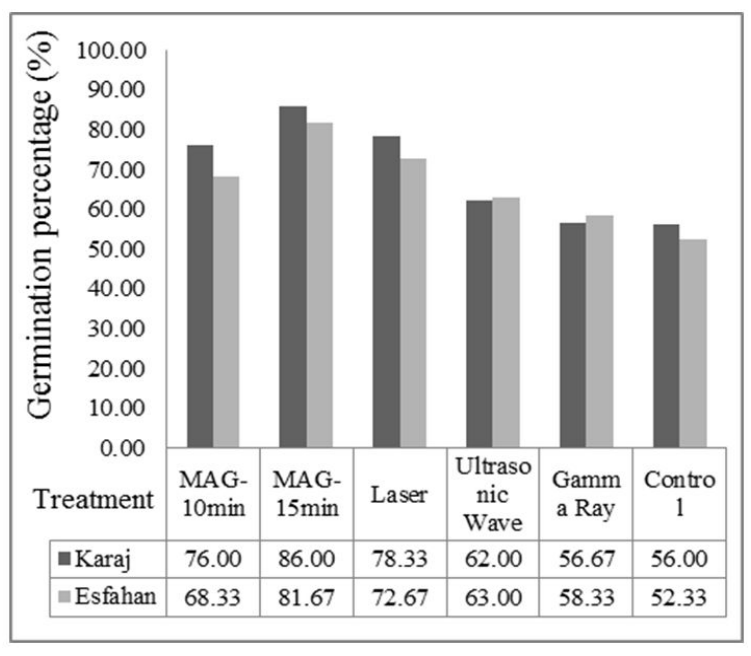
Fig. 1. Germination percentage of two landraces as affected by physical priming centage. Among treatments, ultrasonic wave showed the different plant height, biomass dry weight and percentage most decreasing in germination percentage. Germination of essential oil. Landraces have affected differently by prim- percentage in all treatments was less than control (42%) ing methods in all 3 characteristics (Tab. 2). Results indi- (Tab. 2). cated that plant height (PH) influence was significant due Tab. 1 indicates that there are significance differences to the effect of seed treatments. Priming the seeds in mag- within treatments in plant height (PH), biomass dry weight netic field for 15 min duration had the greatest effect on (BDW), Leaf Area Index (LAI), Leaf Area Ratio (LAR), plant height at both landraces (Tab. 2). Both duration of essential oil percentage (EOP). The results of field study MAG and laser were the impressive treatments on biomass have been shown in Tab. 2. Two lemon balm landraces had dry weight (BDW). MAG-15 min observed the most in-